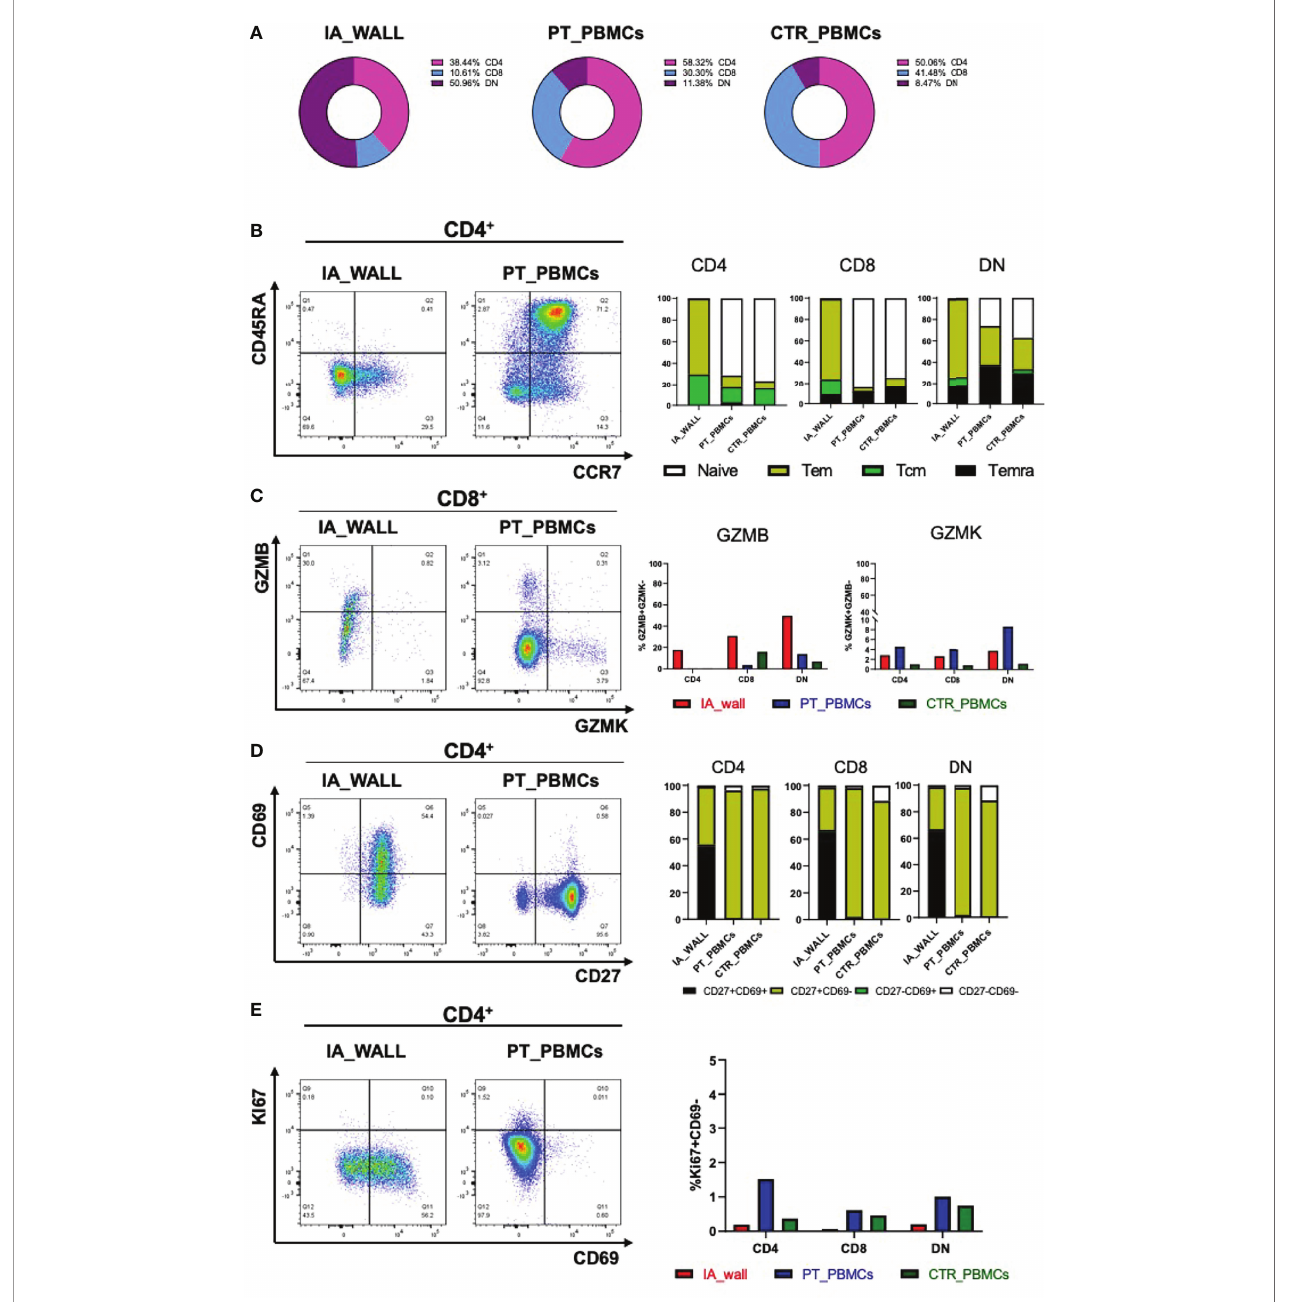
FIGURE 3 | Differentially expressed T-cell differentiation and activation markers in the IA wall. (A) Donut plots report frequencies of CD4+ (magenta), CD8+ (violet) and DN cells (blue) among total CD3+T-cells in the IA_WALL and in PBMCs in the three samples. (B) CD45RA and CCR7 surface expression was analysed to quantify the presence of naïve T-cells (white) and central/effector memory subsets (colored as indicated) in CD4+ (dot plots and left histogram bars) and in CD8+ and DN T-cells (central and right bar histograms). (C) Intracellular GZMB and GZMK expression in CD4+, CD8+ and DN T-cells. Left dot plots show GZMK and GZMB expression in CD8+T-cells in the IA wall and in peripheral blood. Right histogram bars report the frequencies of GZMB/K+ cells among CD4+, CD8+ and DN T-cells in the IA wall (red) and in the blood of the patient (blue) as well as of the pediatric control (green). (D) Surface expression of CD69 versus CD27 in CD4+ (dot plots and left bar histograms) as well as in CD8+ and DN T-cells (central and right bar histograms). The frequencies of CD27+/-CD69+/- cells are colored as indicated. (E) Intracellular expression of the proliferation marker KI67 versus CD69 surface expression in CD4+T-cells in the IA wall and in peripheral blood from the patient is shown in the left dot plots. Percentage of total KI67+ cells among CD4+, CD8+ and DN T-cells in the IA wall (red), in peripheral blood of the patient (blue) and of the pediatric control (green) is shown in the right